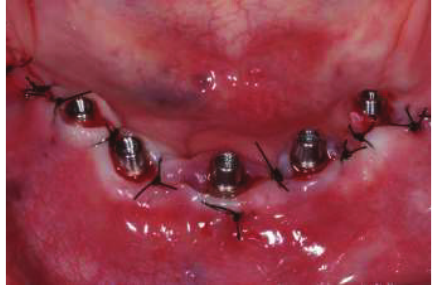
Figure 3: Abutments installed on the implants.